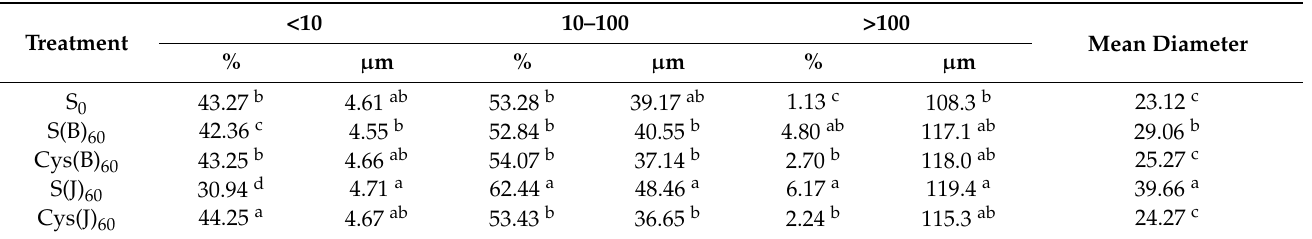
Table 2. Effects of cysteine and inorganic sulfur application at different stages on distribution of GMP particles volume.